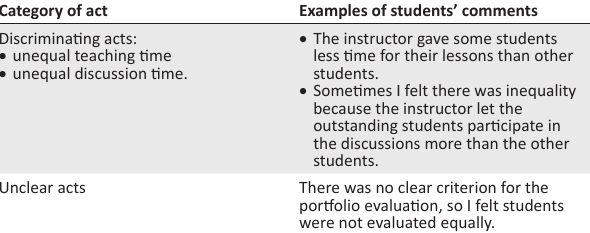
TABLE 6 : Pedagogic acts promoting